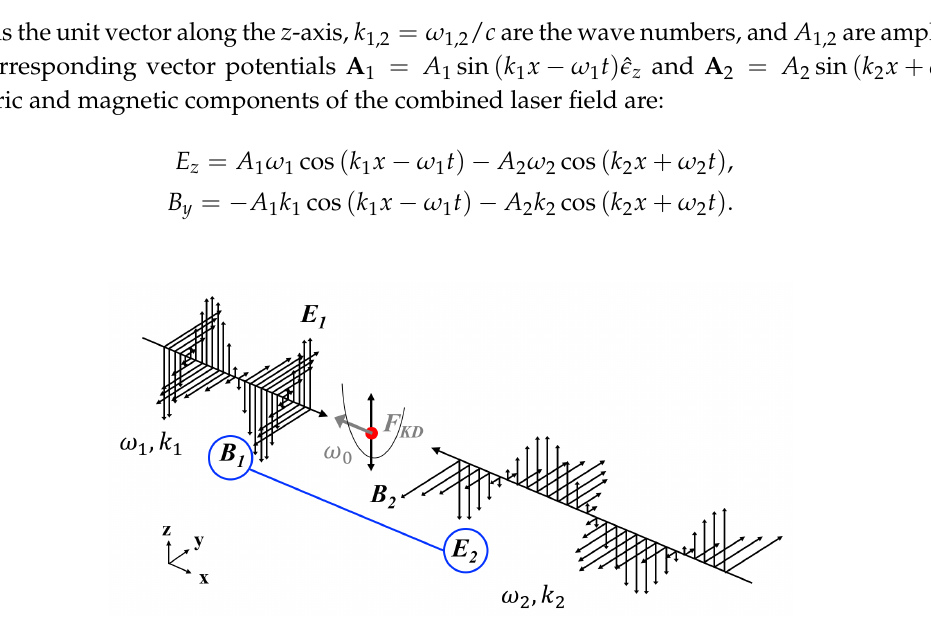
Figure 1. Two counter-propagating laser fields with frequencies ω 1 and ω 2 collaboratively drive the harmonic oscillator with a spatially modulated Kapitza–Dirac force in the direction of wave propagation. The force has a modulation periodicity of 2 π c / ( ω 1 + ω 2 ) , and it oscillates at the difference frequency ω 1 − ω 2 . A particle subject to the perturbation of the classical zero-point electromagnetic field can get pushed to either